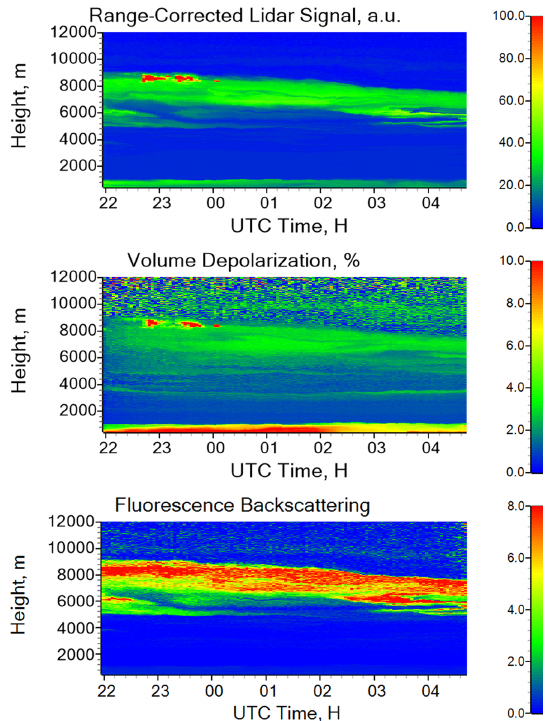
Figure 9. Formation of ice particles at heights above 8km inside the smoke layer on 17–18 September 2020. Spatiotemporal varia- tions in range-corrected lidar signal at 1064nm, volume depolar- ization ratio at 1064nm and fluorescence backscattering coefficient (in 10 − 4 Mm − 1 sr − 1 ).